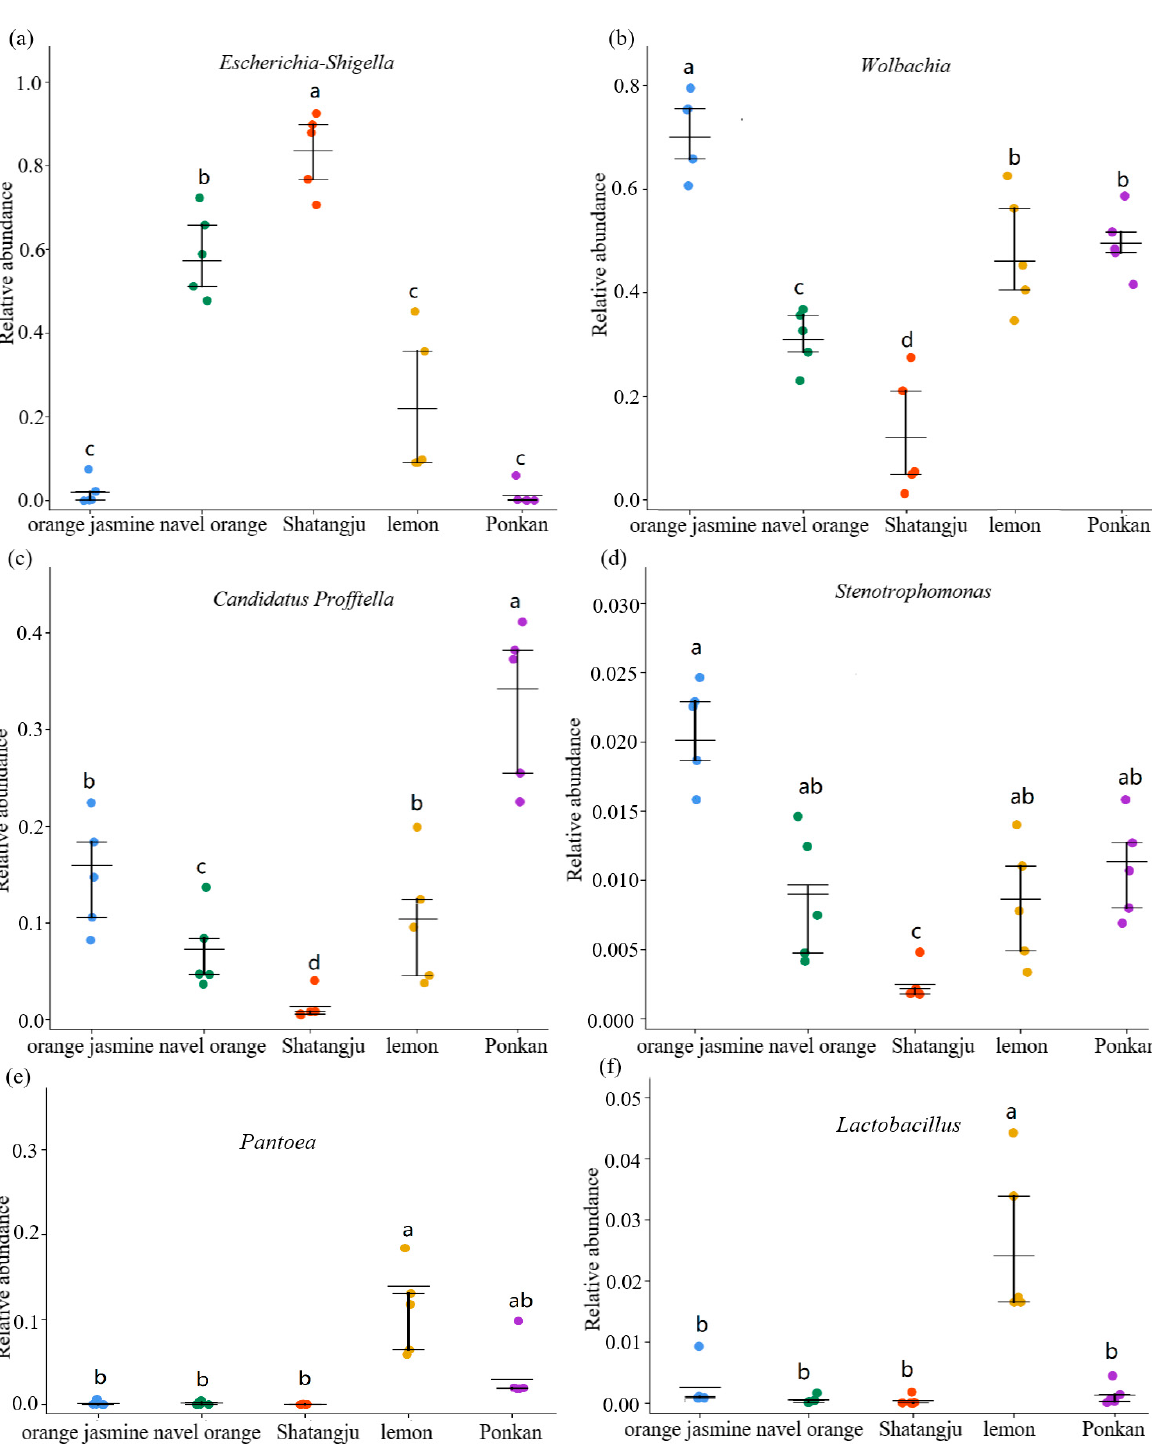
Figure 4. The distribution of six genera ( Escherichia-Shigella ( a ), Wolbachia ( b ), Candidatus Profftella ( c ), Stenotrophomonas ( d ), Pantoea ( e ) and Lactobacillus ( f )) differed significantly in D. citri gut microbes feeding on different host plants. Different letters indicate that the values are significantly different ( p < 0.01).